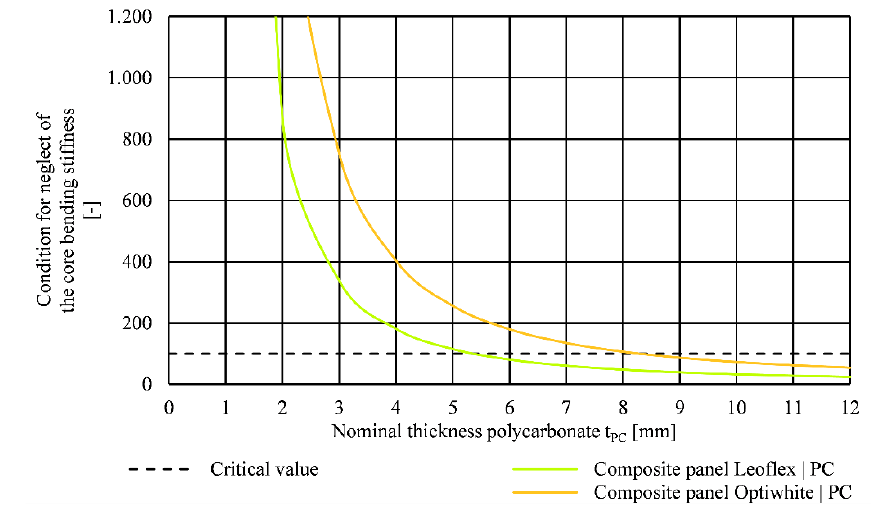
Fig. 6 Weak core approximation for thin glass-polycarbonate composite panels with thin glass Leoflex (t g = 0.85 mm) or thin glass Optiwhite (t g = 2.00 mm) and two polymer interlayers (t TPU = 2.00 mm). The nominal thickness of polycarbonate varies.